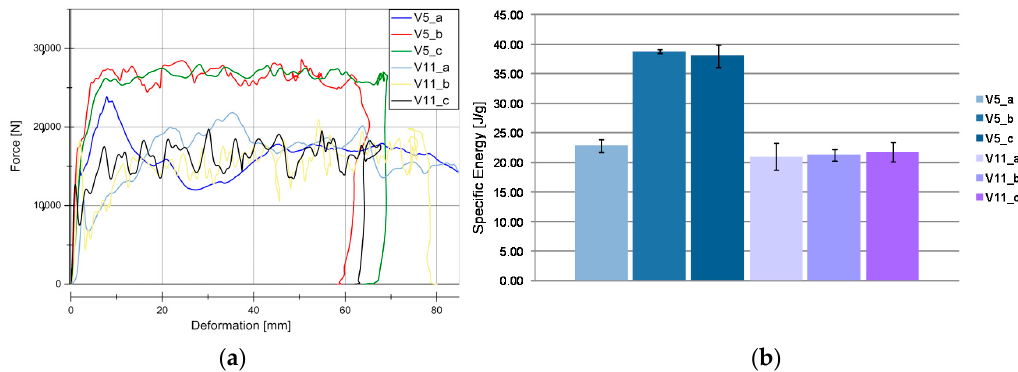
Figure 18. Results for V5 and V11 materials. ( a ) Load-Deformation curve for V5 and V11 materials under different velocity rates under crash tests conditions. ( b ) SEA evaluation for V5 and V11 series (Twill/PLA and Vlies/PLA reinforce influence evaluation).